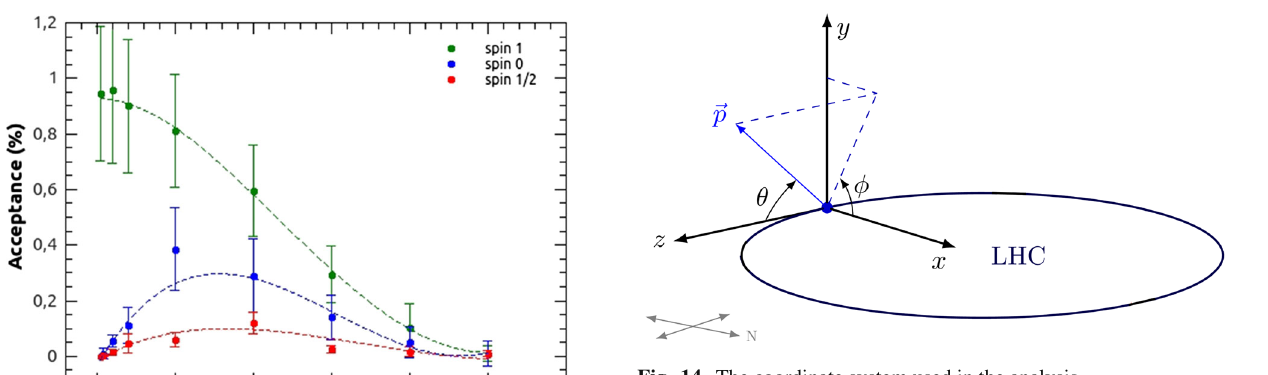
Fig. 14 The coordinate system used in the